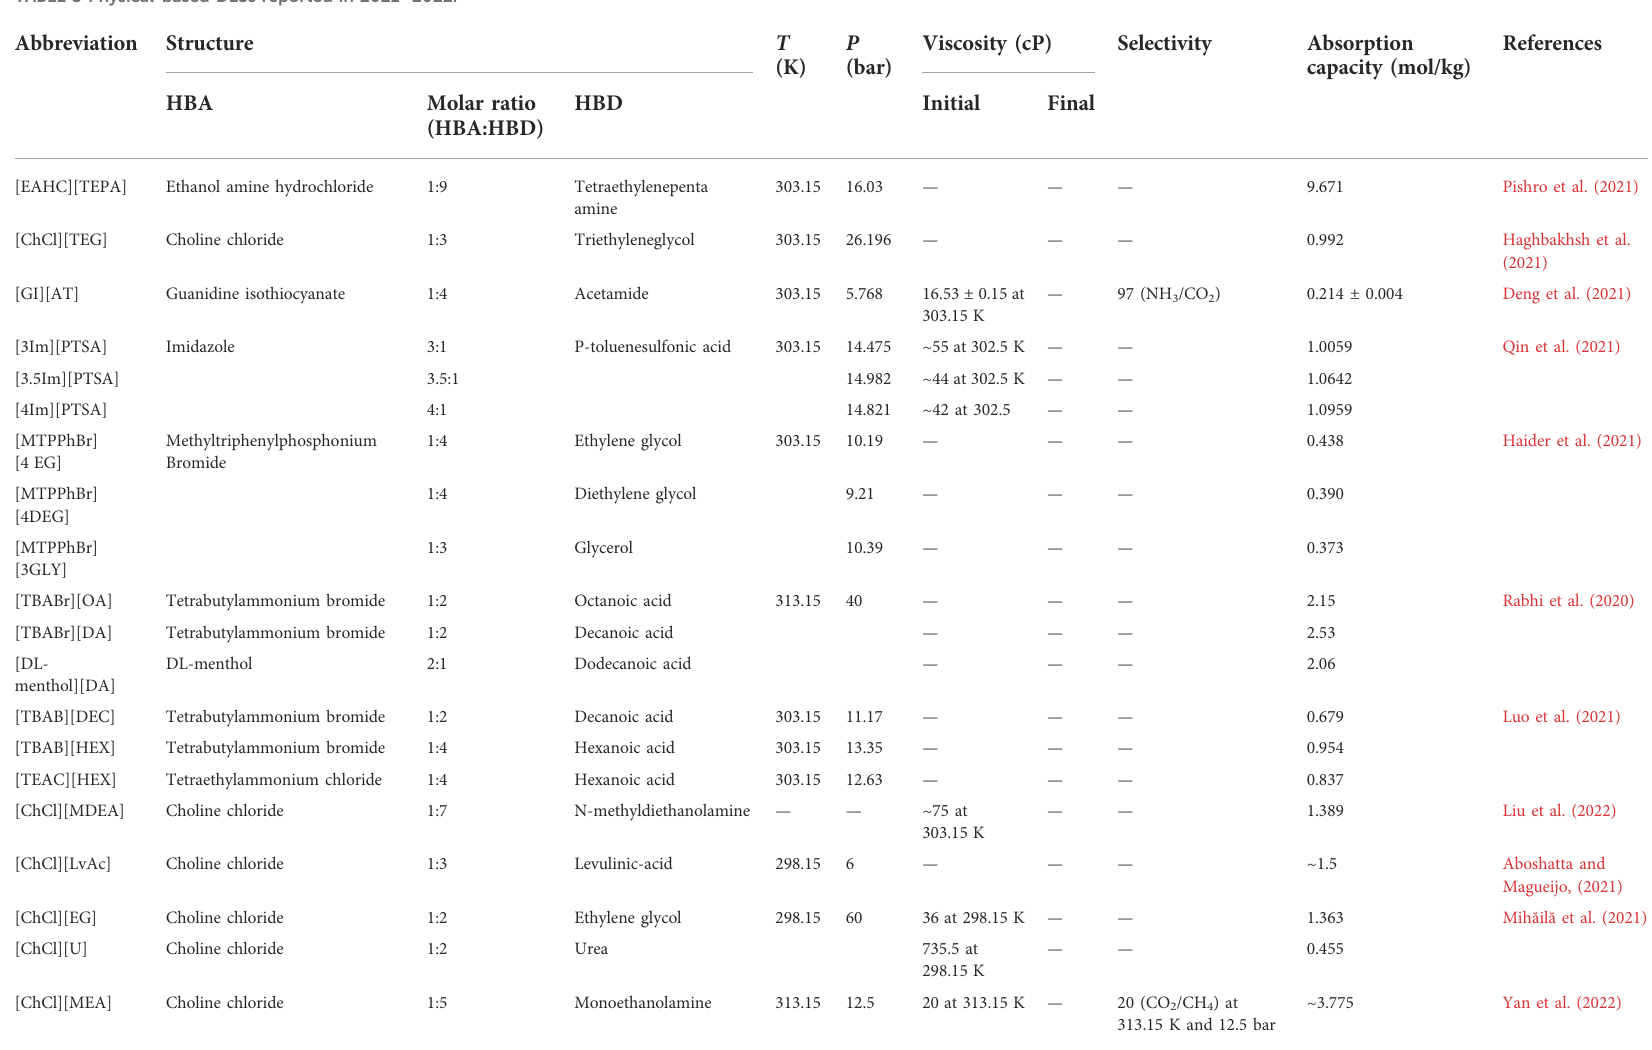
TABLE 3 Physical-based DESs reported in 2021 –